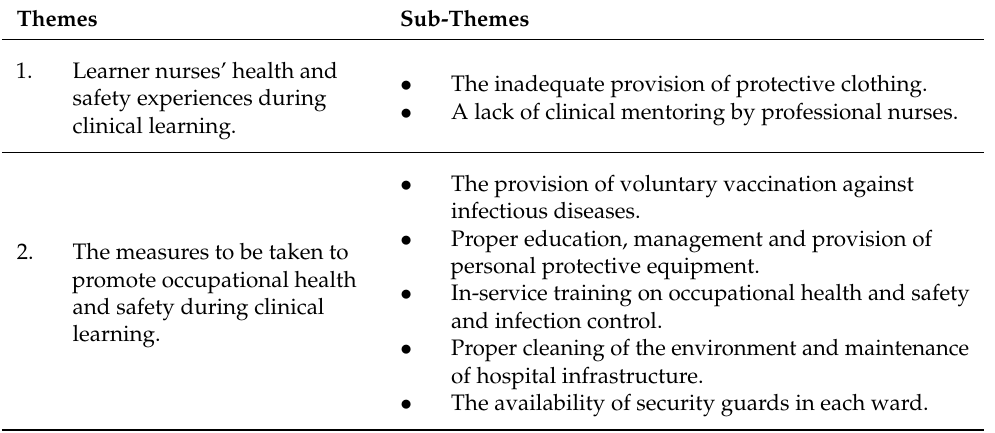
Table 3. Themes and sub-themes regarding the occupational safety of learner